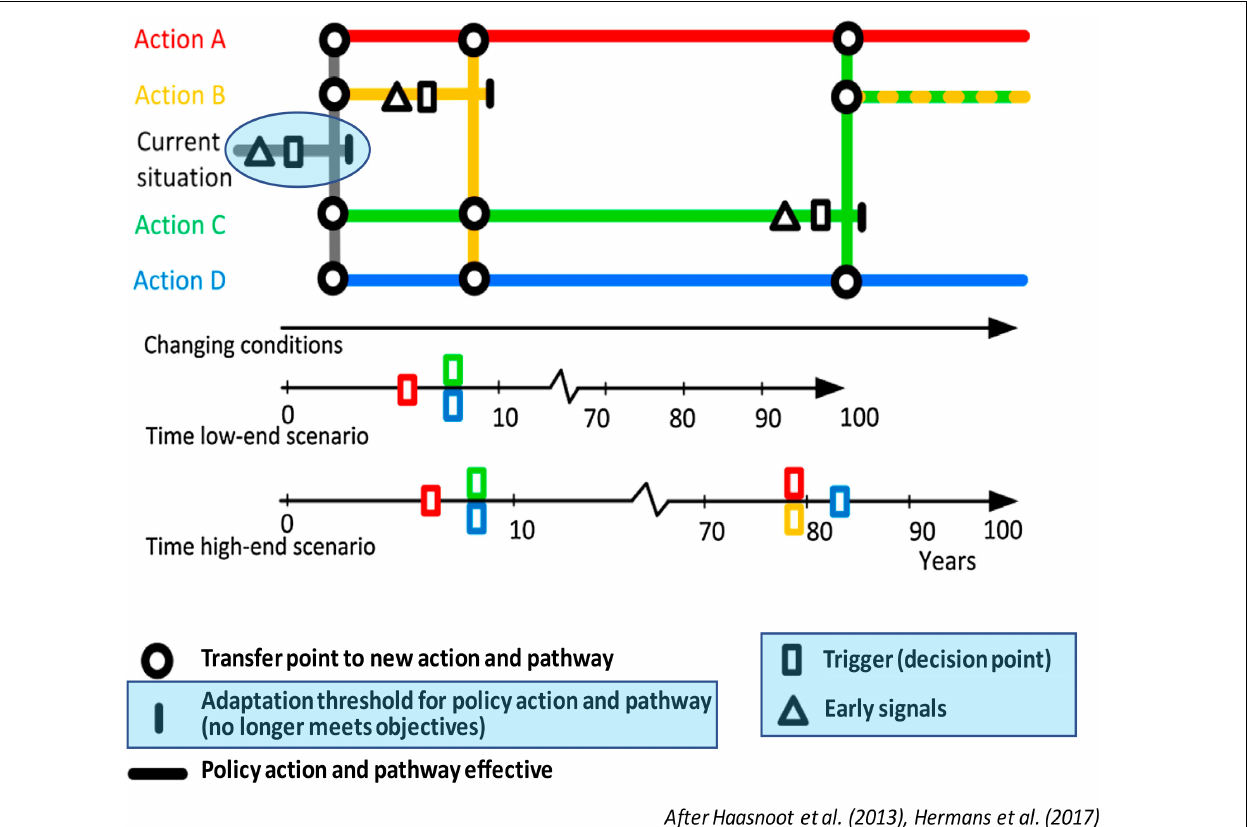
FIGURE 5 | Adaptive pathways showing signals, triggers, and